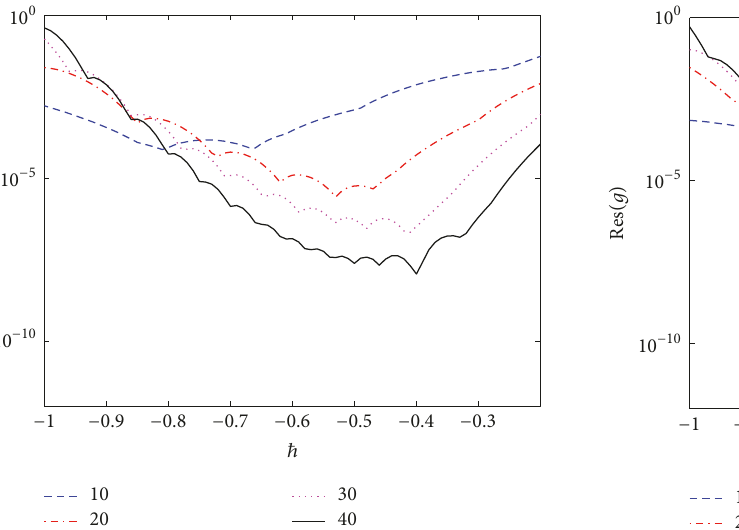
Figure 1: Residual error in 𝑓(𝜂,𝜉) against ℏ at different iteration levels ( 𝜆 = 1 , = 𝛾 = 0.5 , Pr = 3 , Sc = 2 , 𝜉 = 0.45 ).